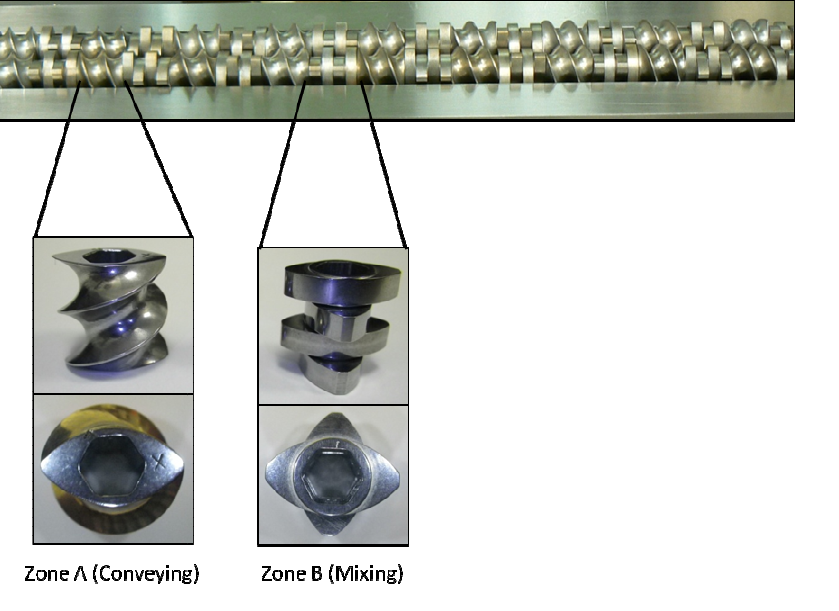
Figure 1. Screw design employed for TSE showing conveying